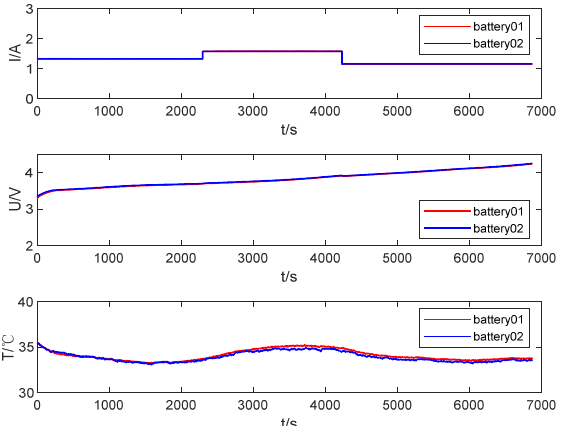
16 of 20 Figure 9. Five-stage constant current charging strategy optimization curve: ( a )fitness value curve; ( b )phase current value curve. The simulation results show that with the increase in the number of iterations, the overall trend of the fitness function curve gradually decreases, which is in line with the expectation of the optimized charging strategy for less charging time and less tempera- ture rise during the charging process. As shown in Figures6–8, the fitness function value of the three-stage constant current charging became stable after the 15th iteration, while the four-stage and five-stage simulations required 47 and 37 times, respectively, to ob- tain the optimal fitness function value. In the simulation process, this paper set the maximum number of iterations as 20, 30, and 50 iterations for multiple simulations, and finally determined 50 as the maximum number of iterations in the simulation. The final fitness function value decreased with the increase in the number of segments, indicating that the five-stage constant current charging had better fitness than the three-stage con- stant current charging and the four-stage constant current charging. It can better meet the needs of reducing charging time and reducing charging temperature rise. However, at the same time, compared with the four-stage constant current charging and the five-stage constant current charging, the three-stage constant current charging has fewer subsections, and the control strategy is simpler and easier to operate. 5. Experimental Verification and Analysis The NCR18650B ternary lithium-ion battery was selected as the experimental object. The capacity test of the battery was carried out first, and the actual capacity of the bat- tery was obtained as 2549 mAh. The maximum charging current in the experiment was set to 1C, and the minimum charging current was 0.05C. According to the optimized charging strategy proposed above, charging experiments were carried out, respectively. In practical applications, 1C CC-CV charging was used to achieve fast charging, but the